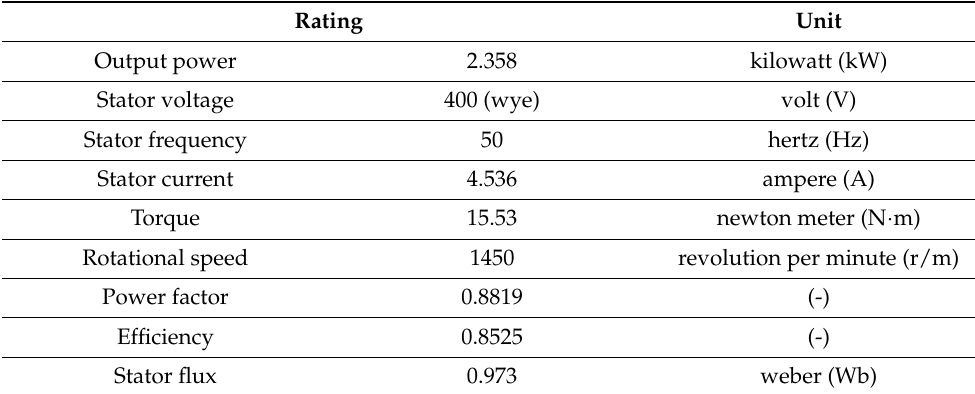
Table A1. The rated values of the squirrel-cage IM of type Sg 132S-4 corresponding to the adopted operating